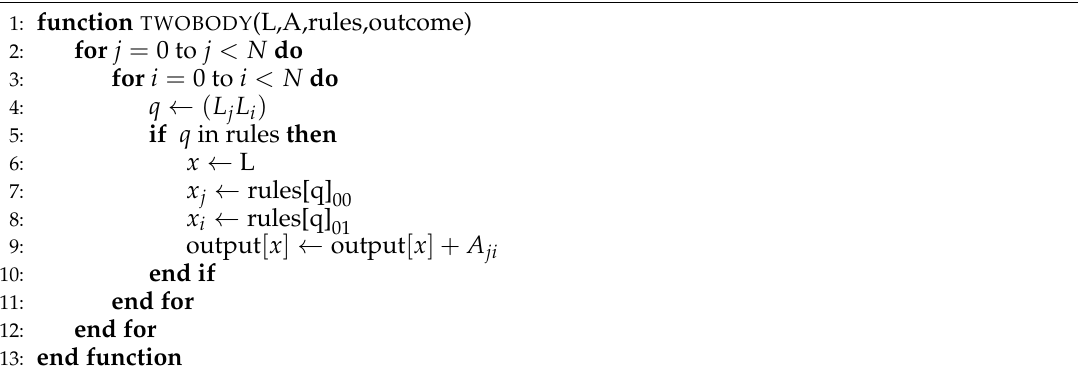
Algorithm A5. Two-Body Off-Diagonal